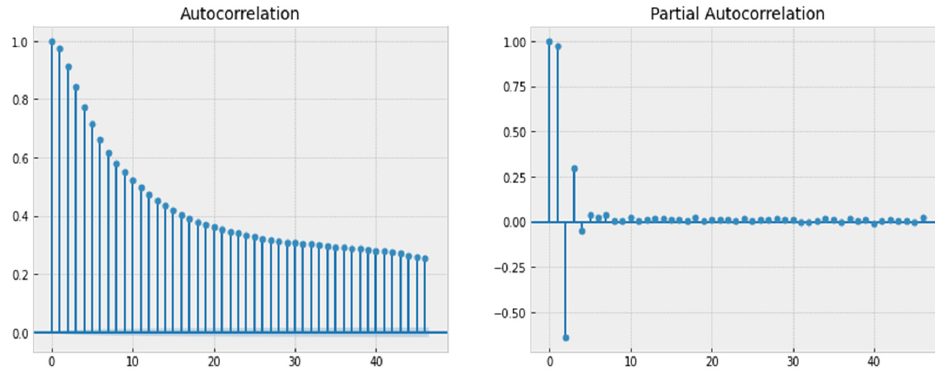
Figure 6. Wave height autocorrelation and partial autocorrelation.